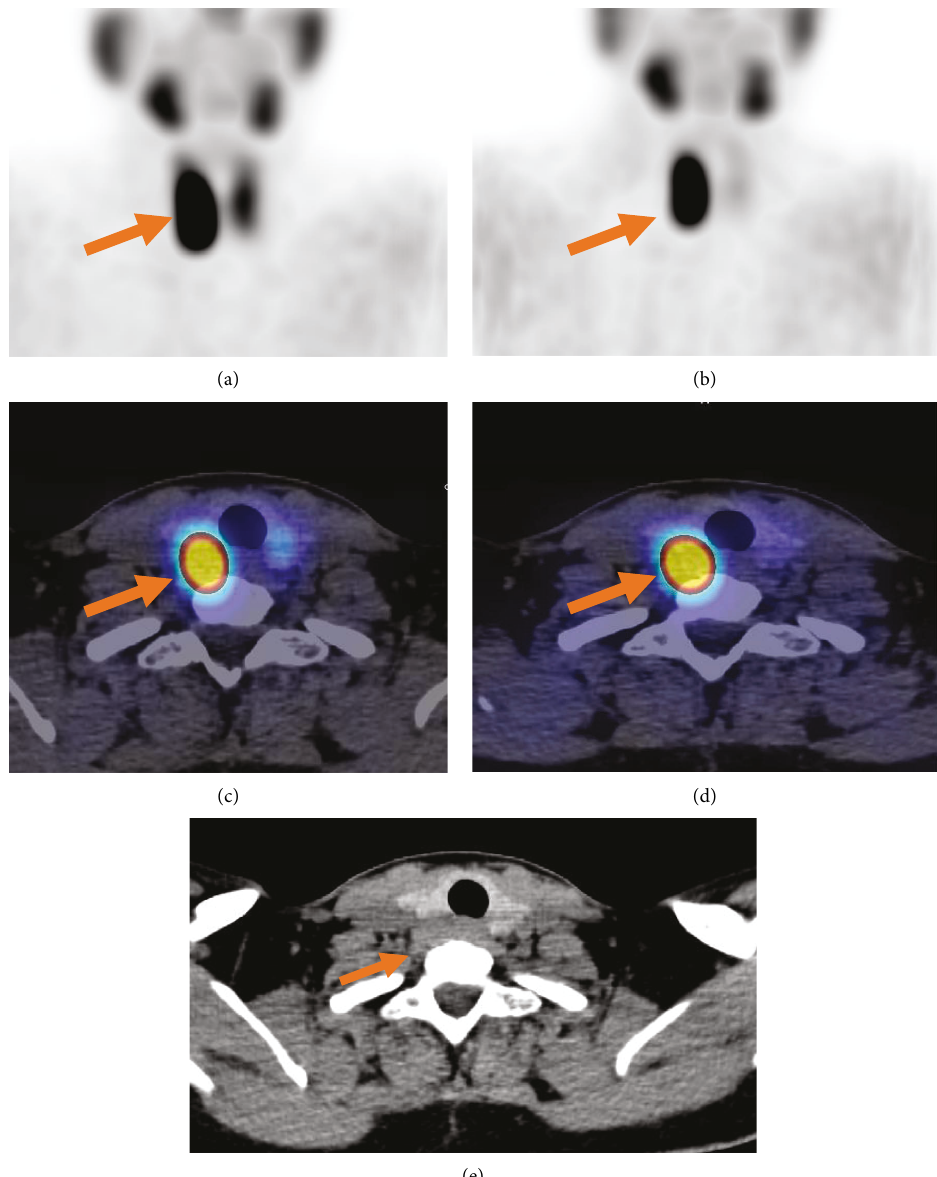
Figure 1: A 38-year-old woman with a giant parathyroid adenoma, localized by a sestamibi scan. Immediate (a) and delayed (2-hour) (b) anterior images of ( 99m Tc)-sestamibi demonstrate a focus of intense sestamibi uptake (arrows). Immediate (c), delayed (2-hour) (d) axial fused SPECT/CT images, and transverse noncontrast CT image (e) localized a circular area with focal uptake posterior to the right thyroid lobe (arrows), which was confirmed histologically to be a giant parathyroid